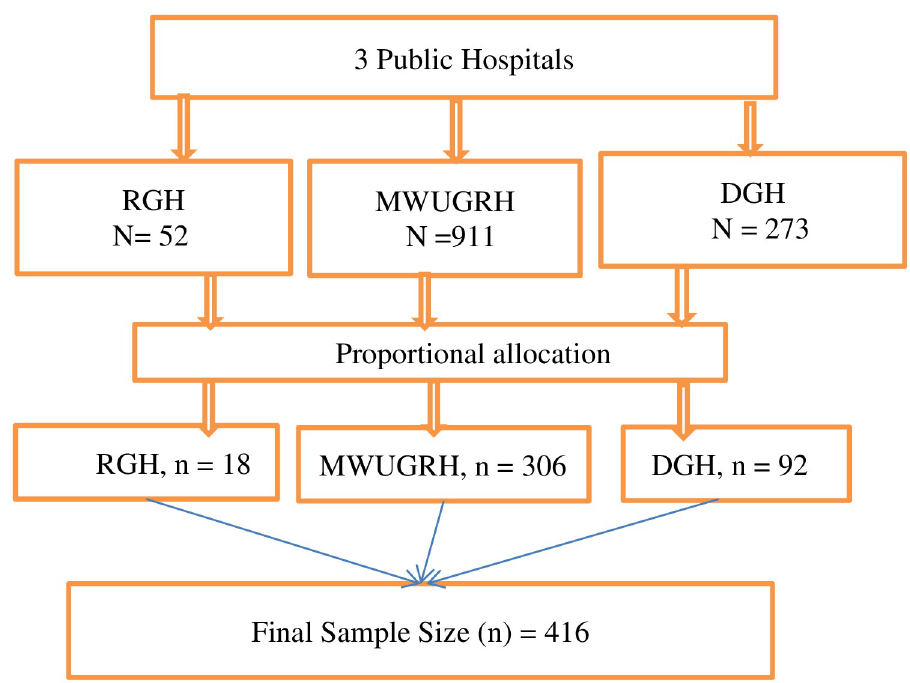
Fig 1. Schematic presentation of sampling technique used to select the study subjects from public hospitals in Bale Zone, South East Ethiopia, 2021.